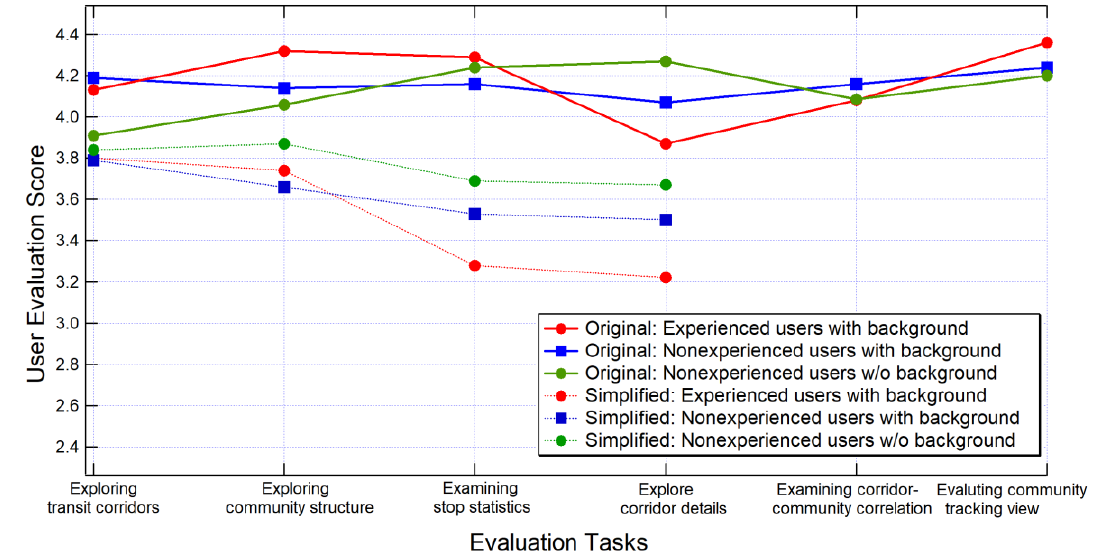
Figure 12. Average evaluation scores for 6 selected geovisual analytics